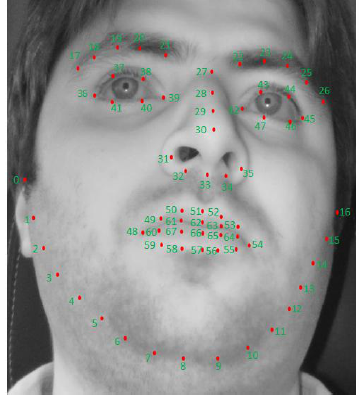
Figure 4. Example of detected facial landmarks.